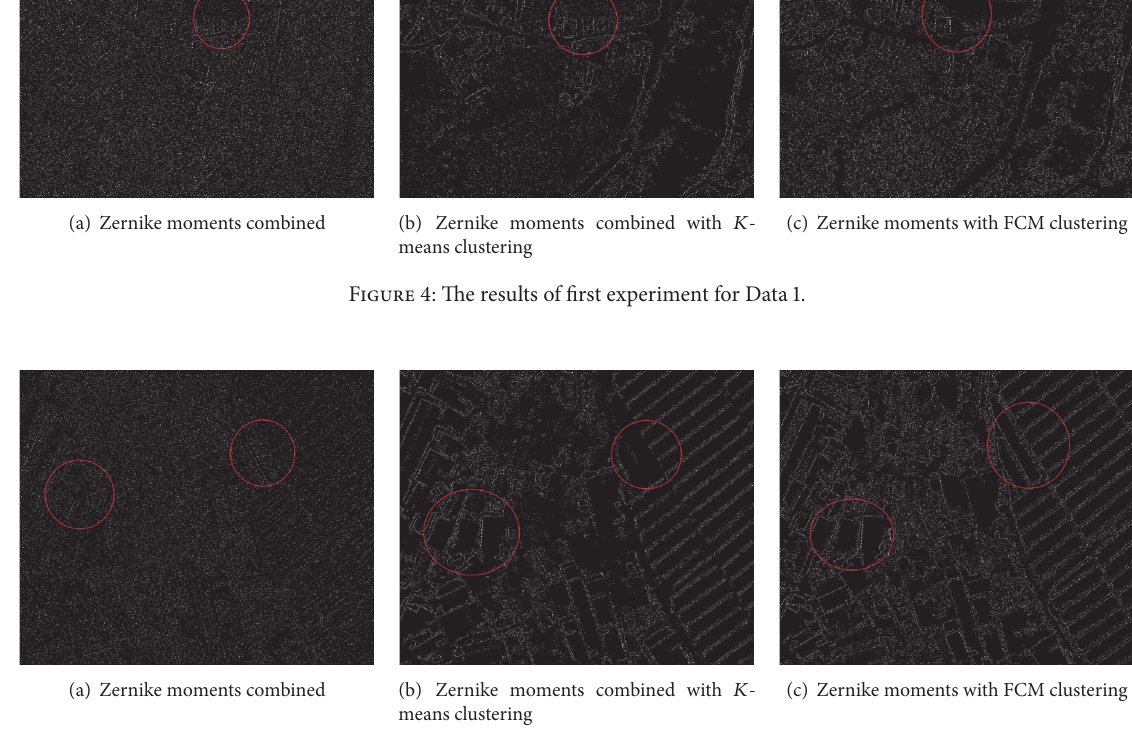
Figure 5: The results of first experiment for Data